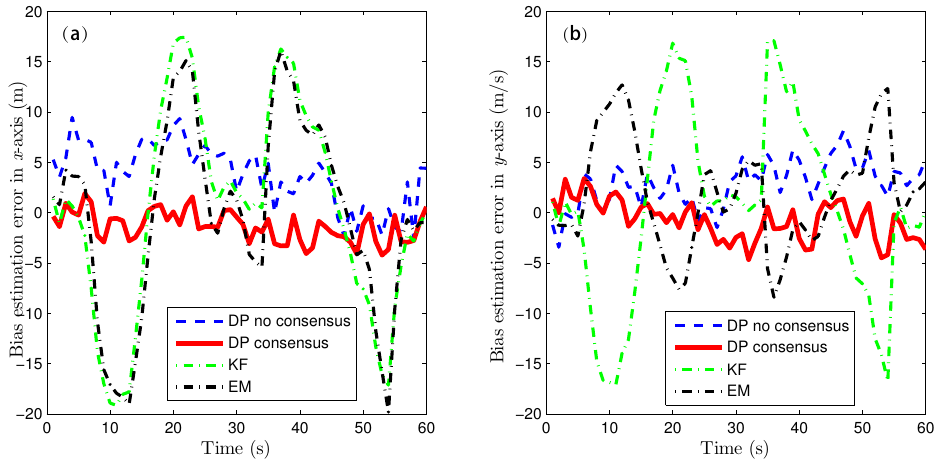
Figure 9. Bias estimation errors using the KF, DP consensus, DP no consensus and EM methods for sensor 4. ( a ) x-axis; ( b ) y-axis.